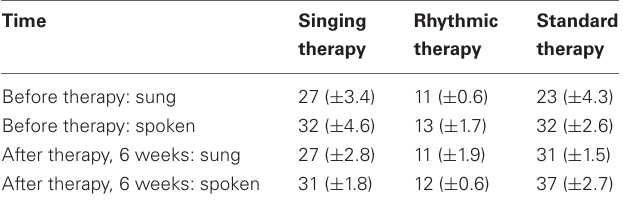
Table 5 | Non-formulaic